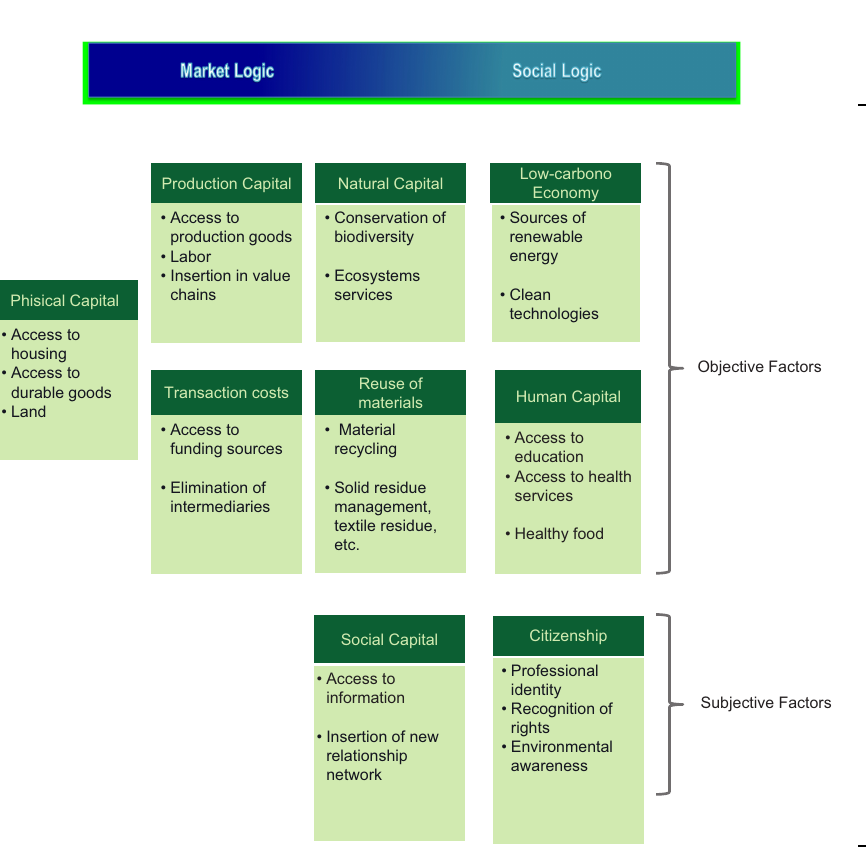
Figure 2. Categories of the generation of socio- environmental